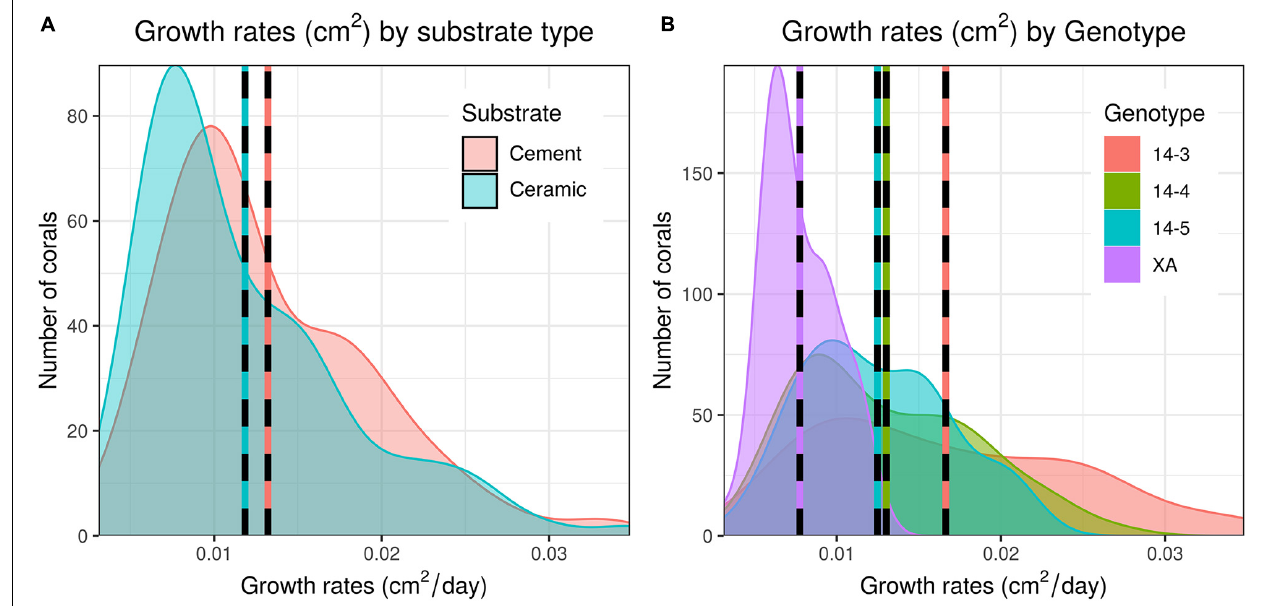
FIGURE 2 | Distribution of daily growth rates of corals between both substrate types (A) and genets (B) . Dashed lines indicate mean growth rates within each group. Untransformed data are shown here; data were Log10 transformed for statistical analysis.